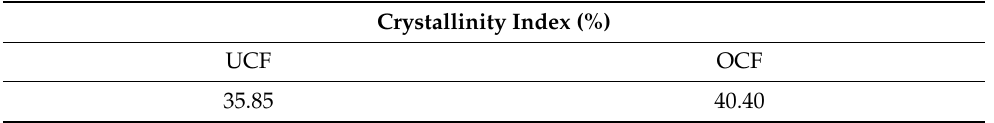
Figure 14. XRD spectra of untreated (black) and treated (red) coir fibers under optimal conditions. Table 8. Crystallinity index values of coir